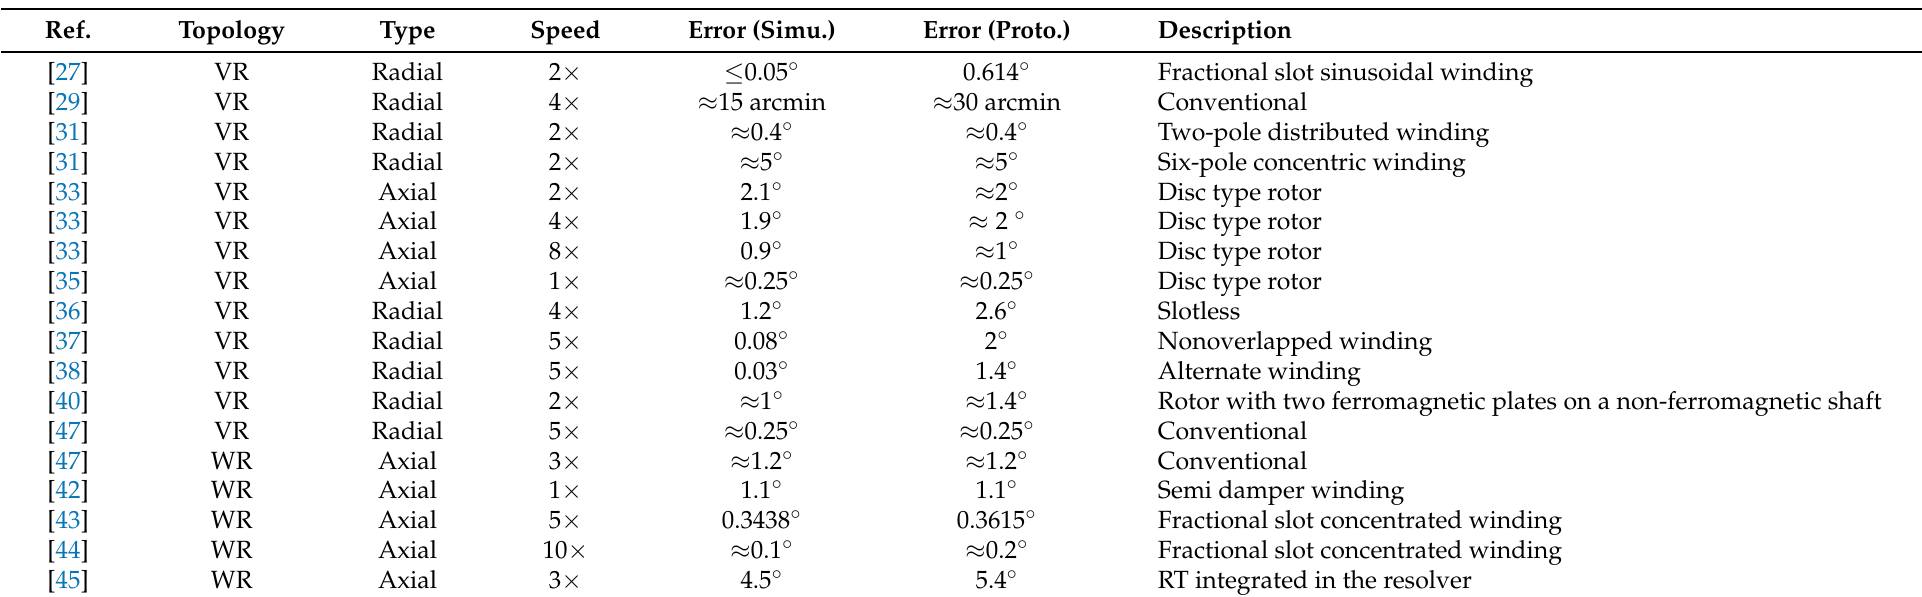
Table 1. Resolver review